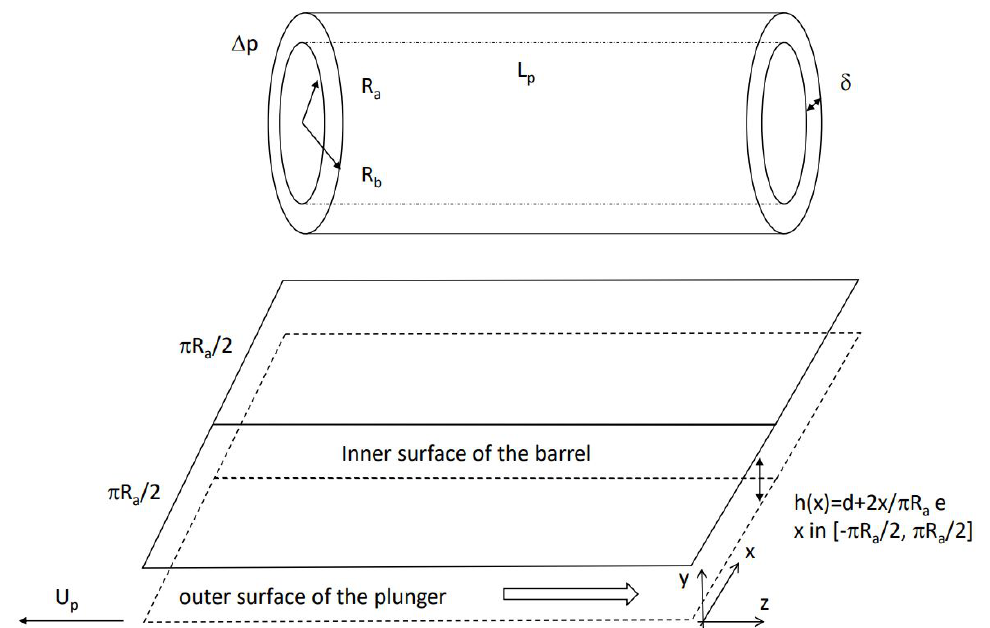
Figure 2. An annulus flow region and its simplified rectangular domain with the width direction in the circumferential